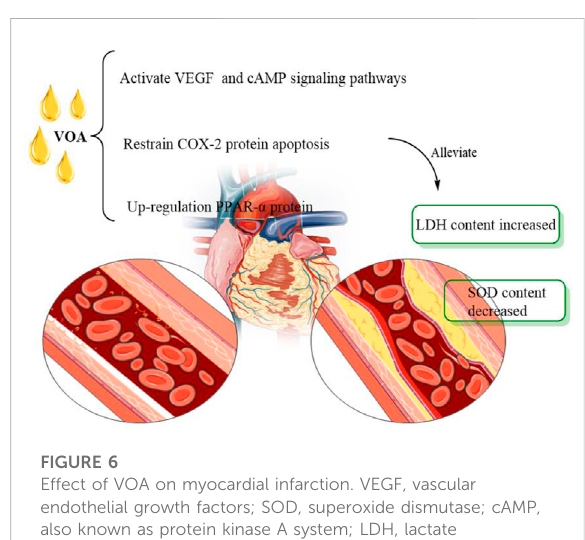
FIGURE 6 Effect of VOA on myocardial infarction. VEGF, vascular endothelial growth factors; SOD, superoxide dismutase; cAMP, also known as protein kinase A system; LDH, lactate dehydrogenase; COX-2,